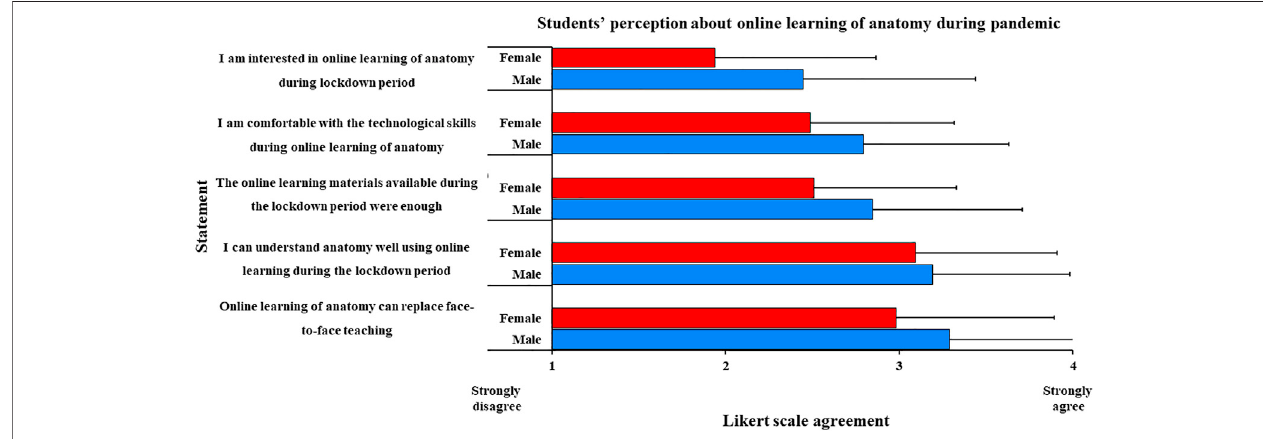
FIGURE 1 | A diagram showing students ’ perception about online learning of anatomy during the pandemic. Data were represented as mean ± SD.